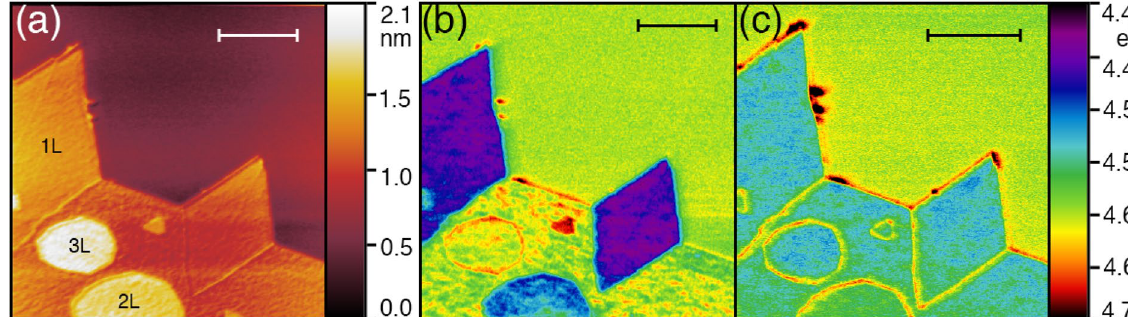
Figure 5. Map of changes in work function φ after annealing. Topography image ( a ) with map of work MoS 2 function 3 hours ( b ) and 24 hours ( c ) after annealing. Inset scale bars represent 500 nm in all three figures.